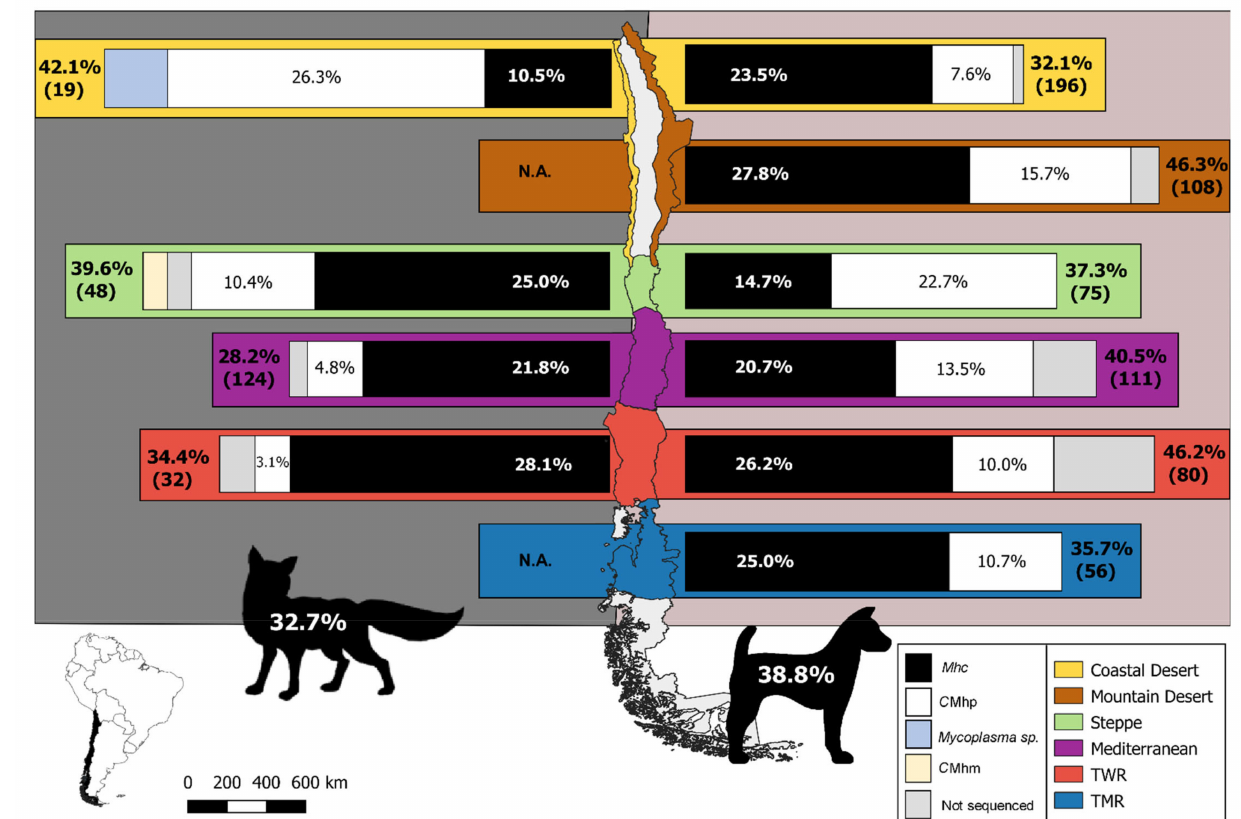
Figure 1. Map of the study areas, showing hemoplasma prevalence in the surveyed foxes (left) and rural dogs (right) across the different bioclimatic regions of Chile. Sample size is in parenthesis. N.A.: Not Assessed, Mhc : Mycoplasma haemocanis , C Mhp: Candidatus Mycoplasma haematoparvum, C Mhm: Candidatus Mycoplasma haematominutum, TWR: Temperate Warm Rainy, TMR: Temperate Maritime